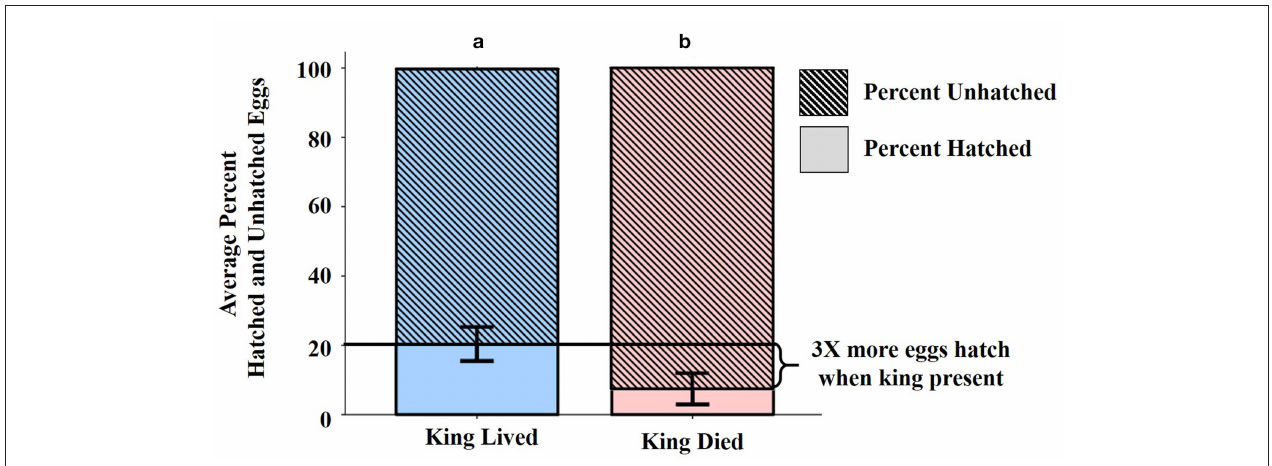
FIGURE 5 | Average percent hatched and unhatched eggs as a function of king death. When kings lived, an average of 20% of a colony’s eggs hatched compared to an average of only 7% when kings died. Differing letters denote statistical significance. Error bars represent ± 2 SD around the